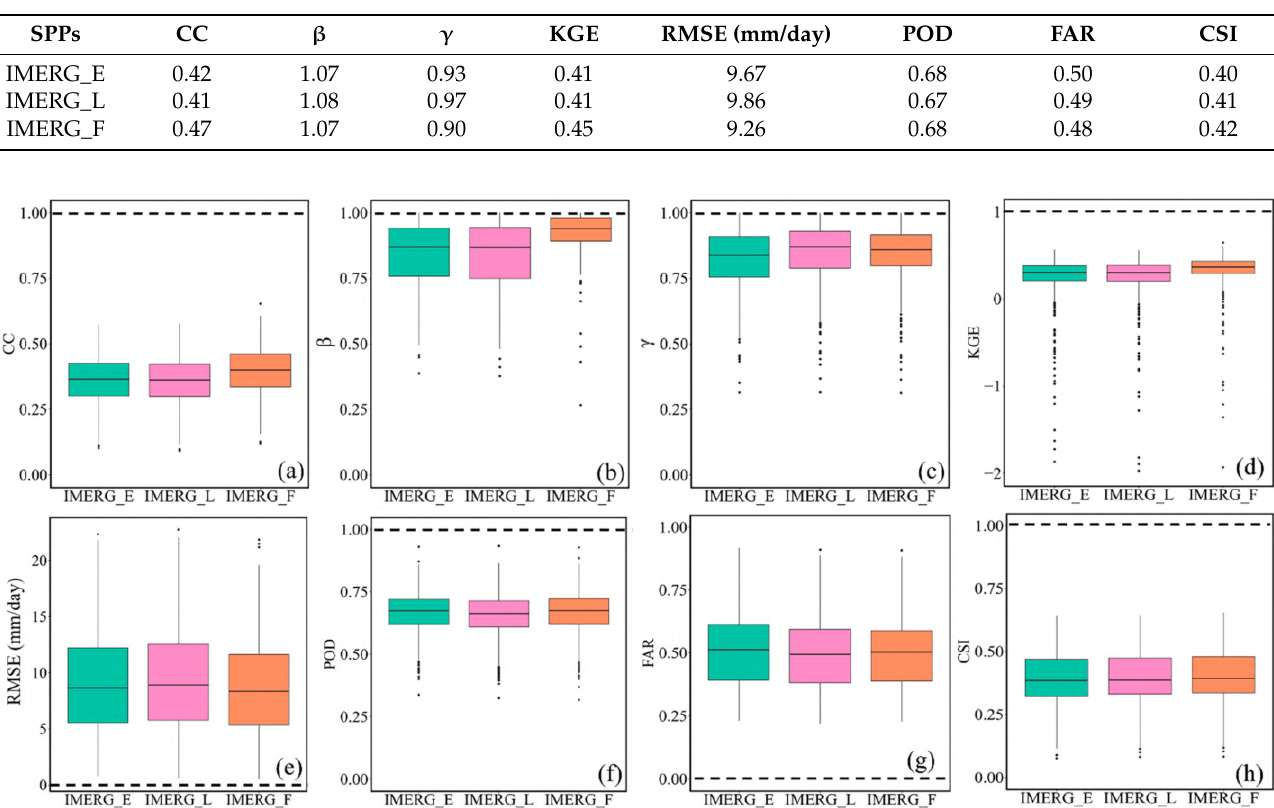
Table 2. Overall performance associated with IMERG products from 2008 to 2017 at daily level across China.